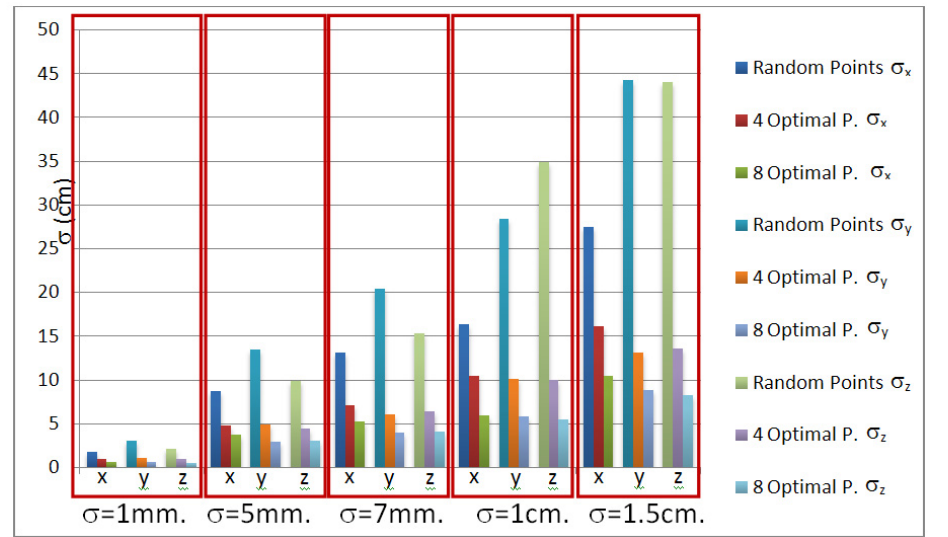
Figure 6. Standard noise deviation in results for 100 simulations (hyperbolic